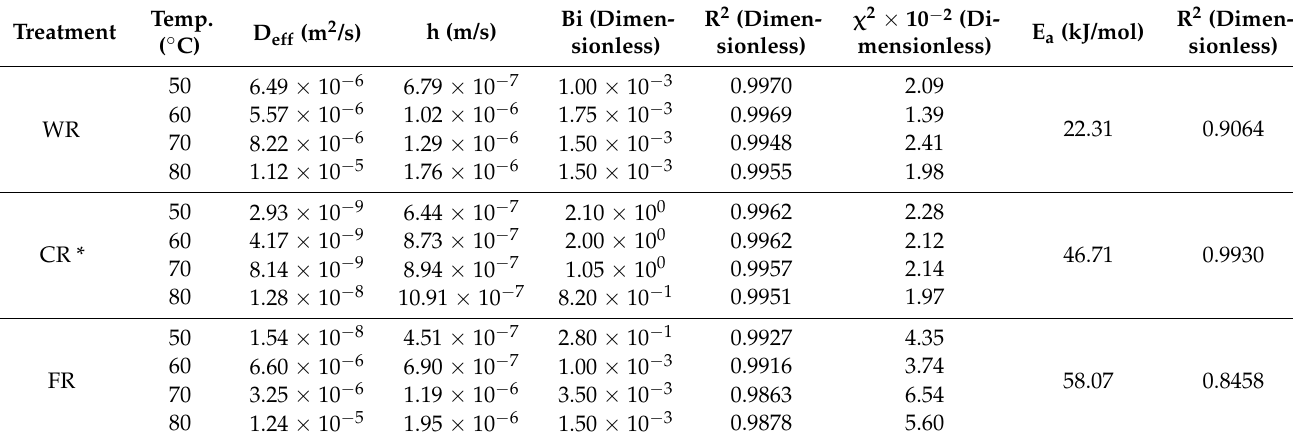
Table 3. Effective water diffusivity (D eff ), convective mass transfer coefficient (h), Biot number (Bi) and activation energy for different drying conditions of whole residue (WR), crushed residue (CR) and residue in the form of foam (FR). Treatment